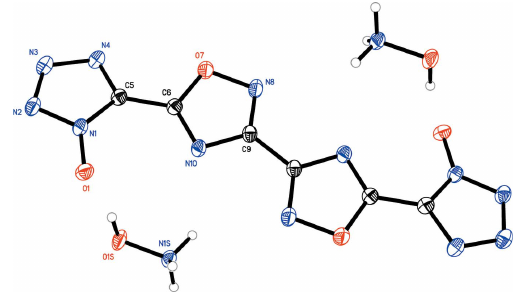
Figure 2 Molecular structure of 2 , showing the atom-labeling scheme. Displace- ment ellipsoids are drawn at the 50% probability level.